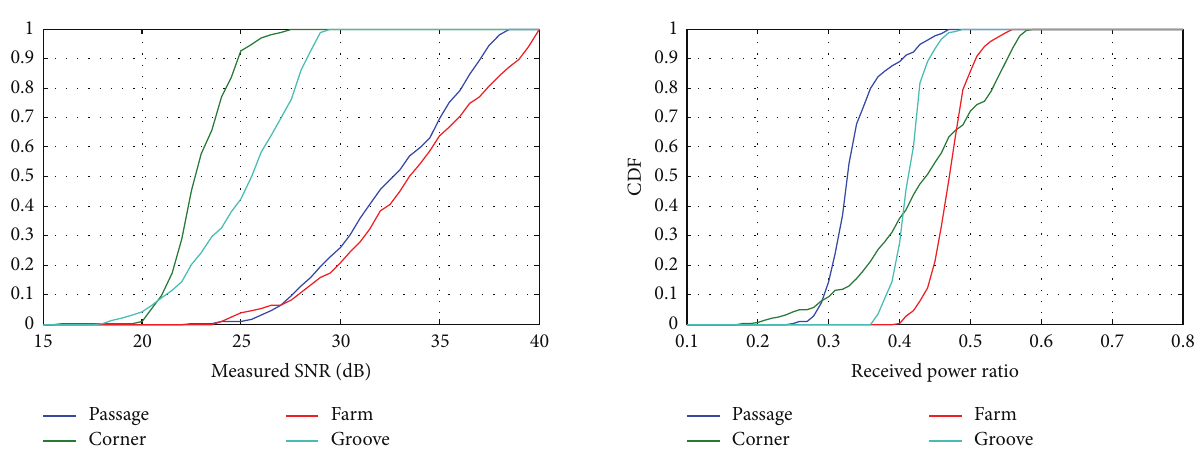
Figure 9: Distribution plot for measured SNR.